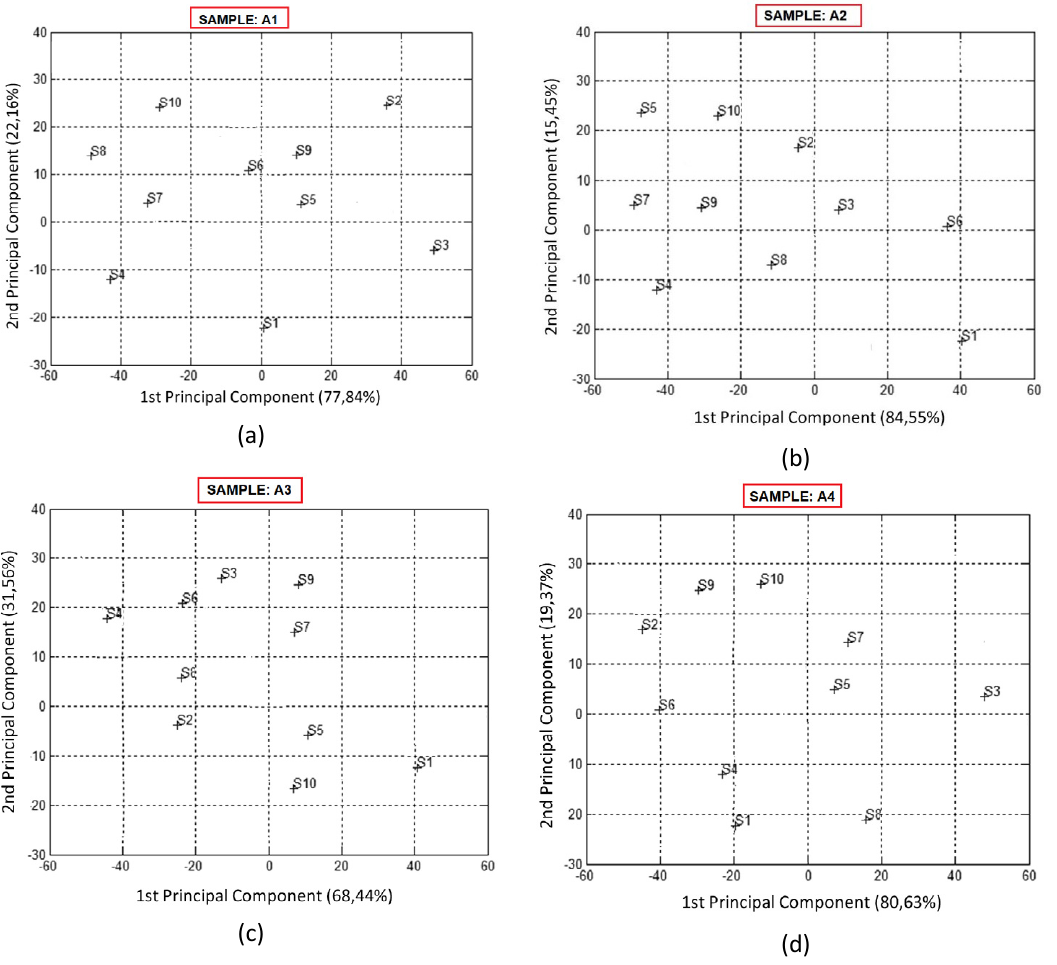
Fig. 7. Analysis of the Main Component (PCA) obtained for the sensors in the presence of effluent samples, referring to the dif- ferent polymeric complexes deposited on the interdigitated microelectrodes. In (a) sample A1, (b) sample A2, (c) sample A3 and (d) sample